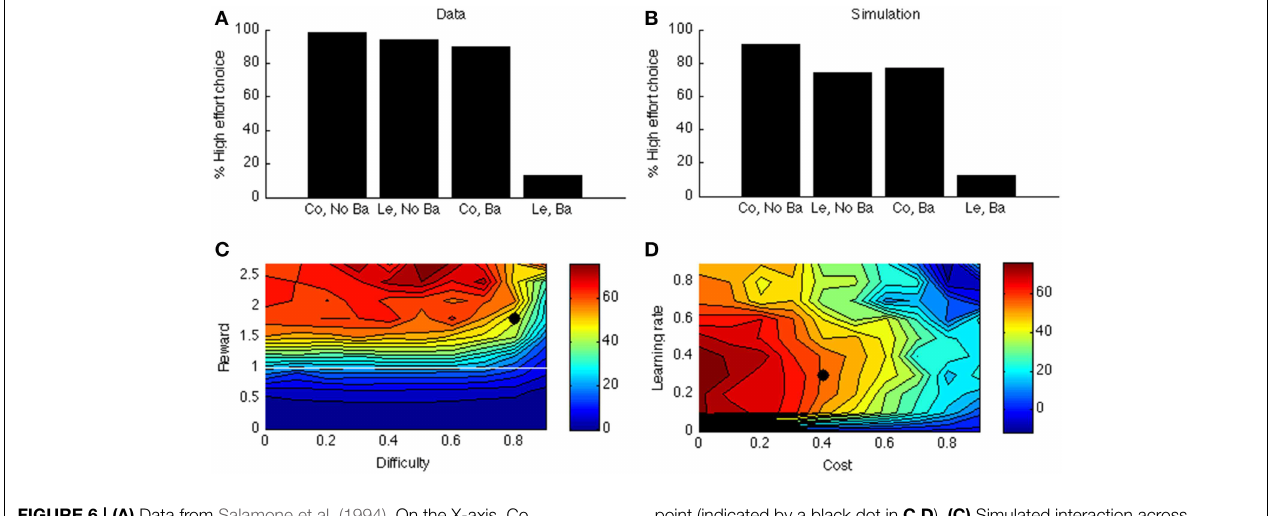
point (indicated by a black dot in C,D ). (C) Simulated interaction across different levels of reward and difficulty. (D) Simulated interaction across different levels of learning rate and